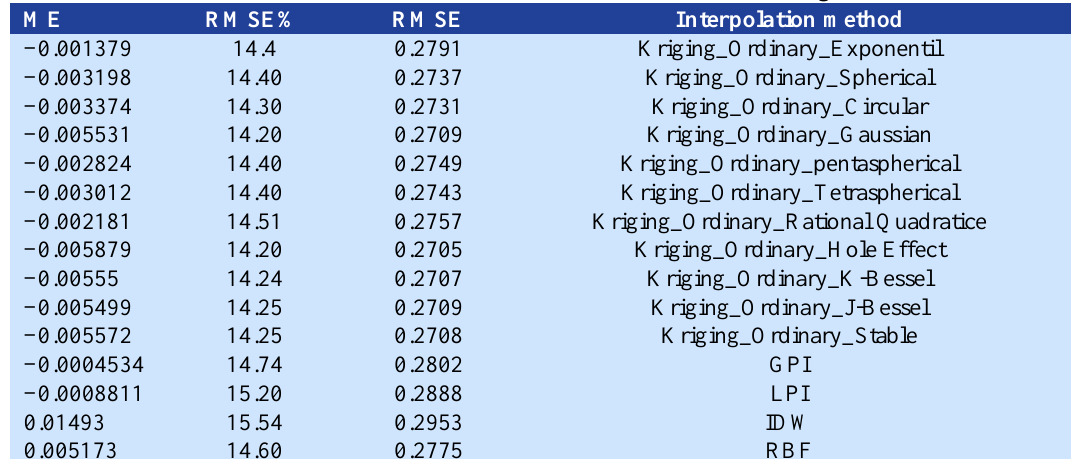
Table 3. Selection of the most suitable model for evaluation on